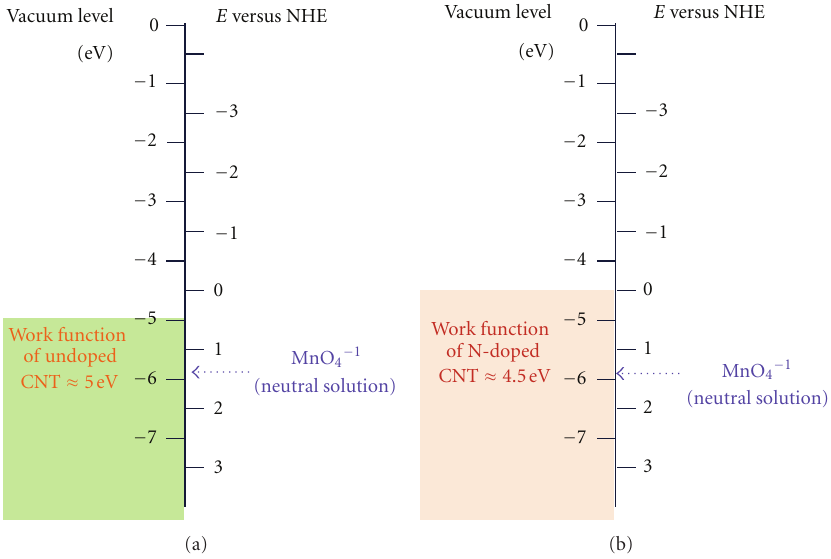
Figure 6: Energy diagram between the (a) Undoped CNTs and (b) N-doped CNTs and the KMnO 4